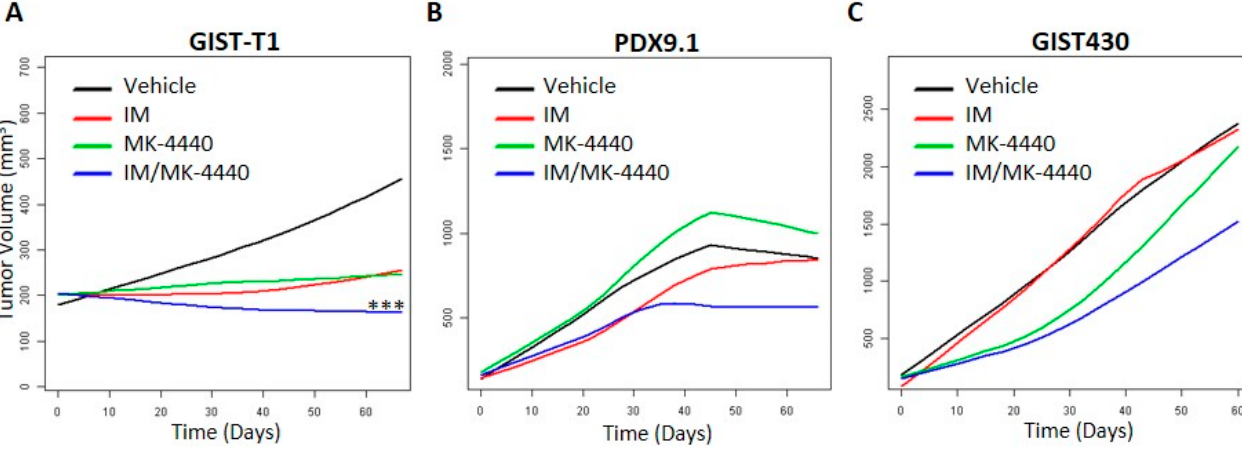
Figure 6. Combination of IM and MK-4440 inhibits GIST growth in vivo. Smoothed tumor growth curves (tumor volume vs. time) were computed for each treatment using the lowess smoother in the R statistical language. ( A ) A statistically significant decrease in the rate of GIST-T1 xenograft tumor growth was observed for IM/MK-4440 combination (blue) vs. standard monotherapy with IM (red) ( p < 0.0006). Tendency to decrease in the rate of tumor growth in PDX9.1 ( B ) and GIST430 xenograft ( C ) models under treatment with IM/MK-4440 combination (blue) were observed with no statistical significance in comparison with IM monotherapy (red).